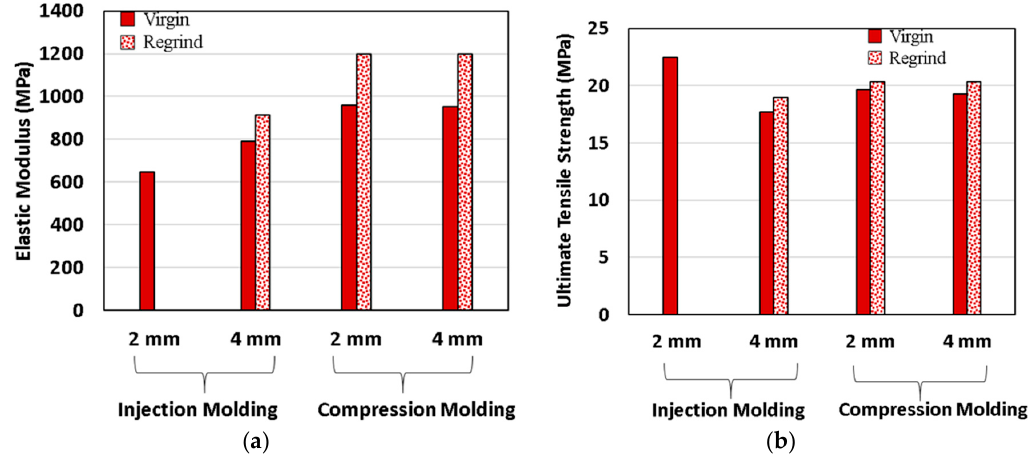
Figure 3. ( a ) Elastic modulus and, ( b ) ultimate tensile strength comparison due to thickness effect for virgin and regrind HDPE at room temperature (RT) and 6 × 10 − 4 s − 1 strain rate.